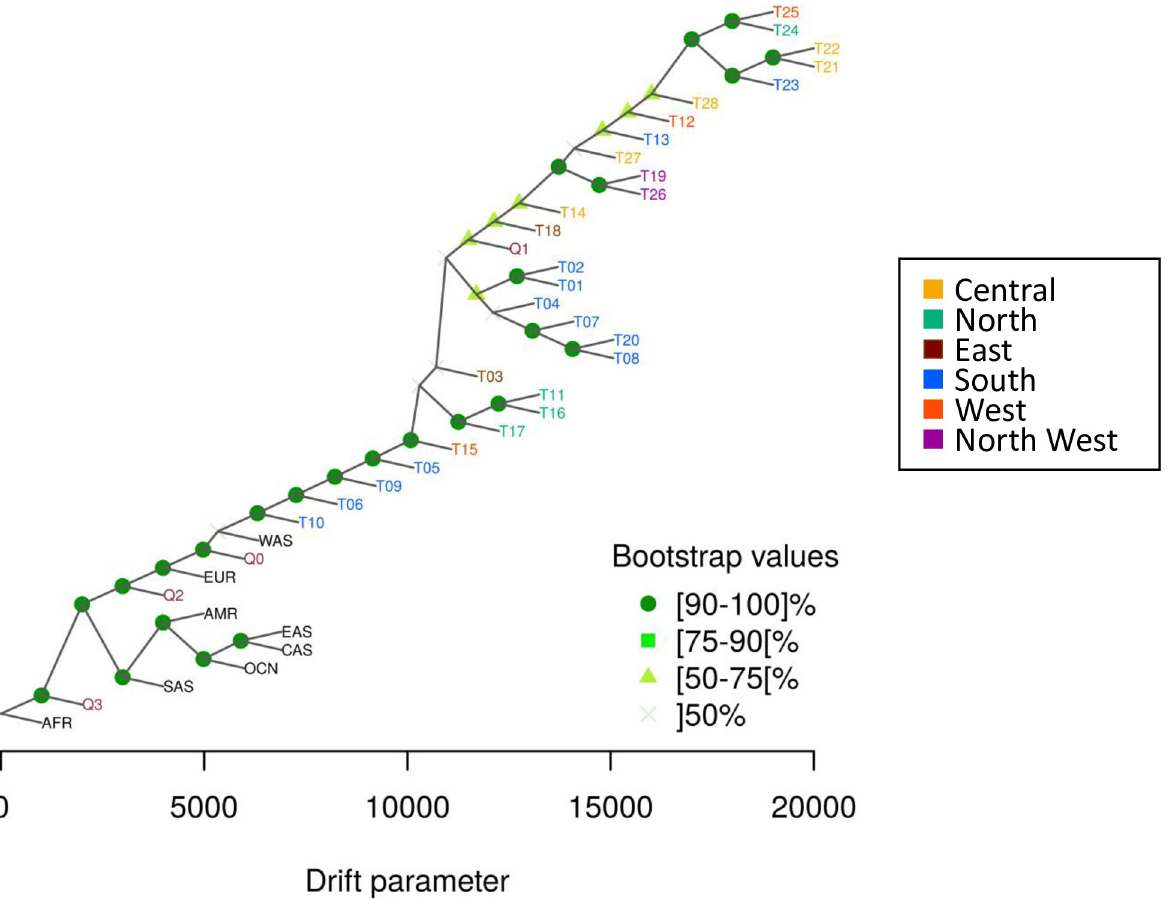
Fig 4. TreeMix representation of indigenous Arab populations with reference populations. Saudi tribes (T01-T29) are coded by regional colors. Bootstrap confidence value is indicated by distinct symbols at each node. AFR; Africa, AMR; America, CAS; Central Asia, EAS; East Asia, EUR; Europe, OCN; Oceania, SAS; South Asia, WAS; West Asia, Q1; Bedouin in Qatar genome project, Q2; Persian-South Asian in Qatar genome project, Q3; African in Qatar genome project, Q0; unassigned in Qatar genome